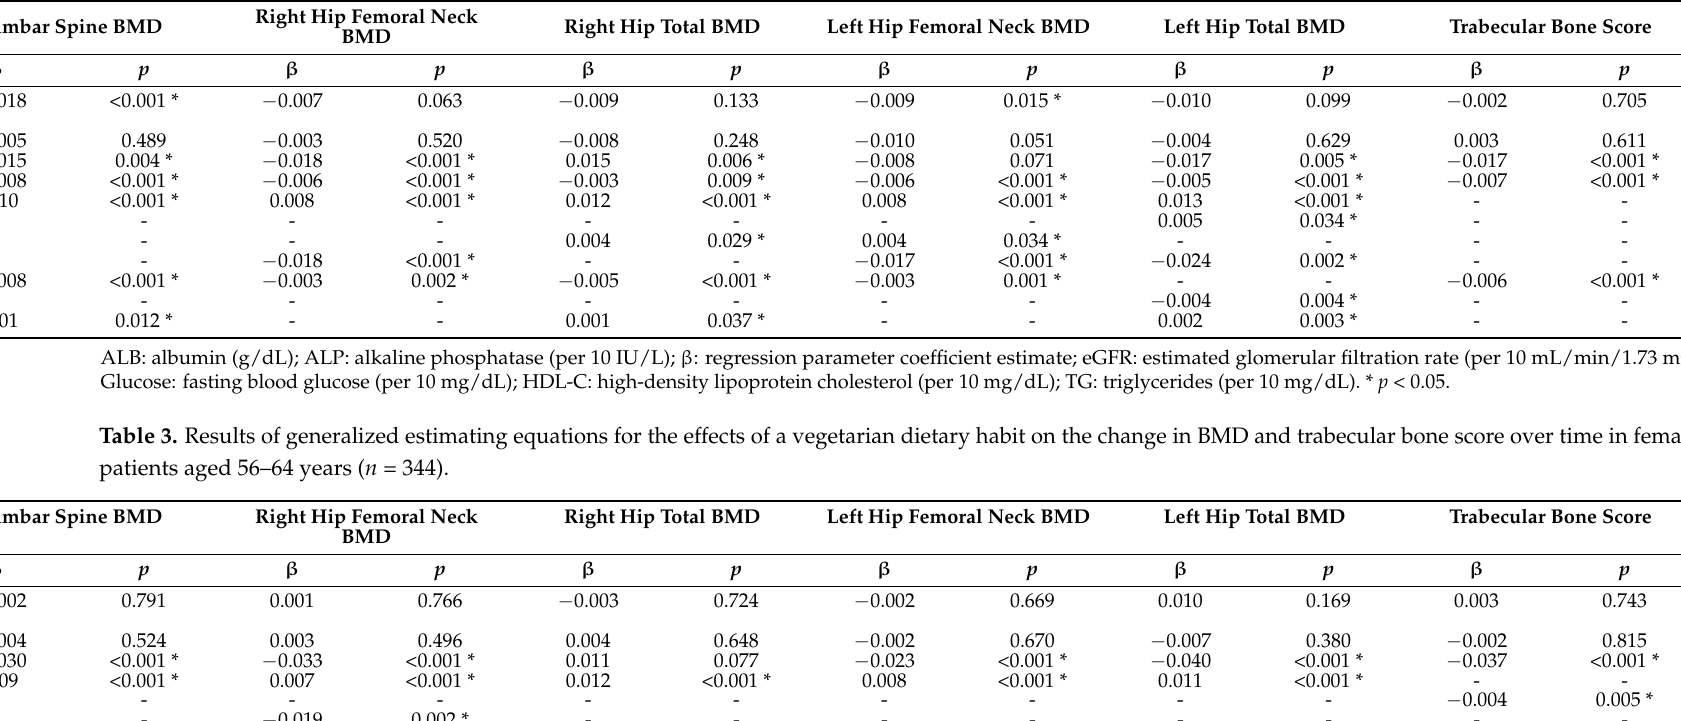
Table 2. Results of generalized estimating equations for the effects of a vegetarian dietary habit on the change in BMD and trabecular bone score over time in female patients aged 40–55 years ( n = 458).